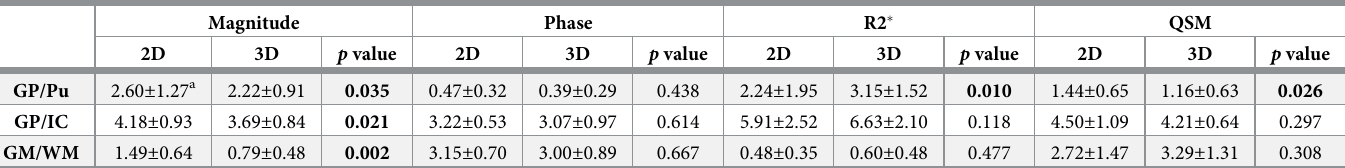
Table 2. Contrast to noise ratios in different ROIs from 2D SMS and 3D